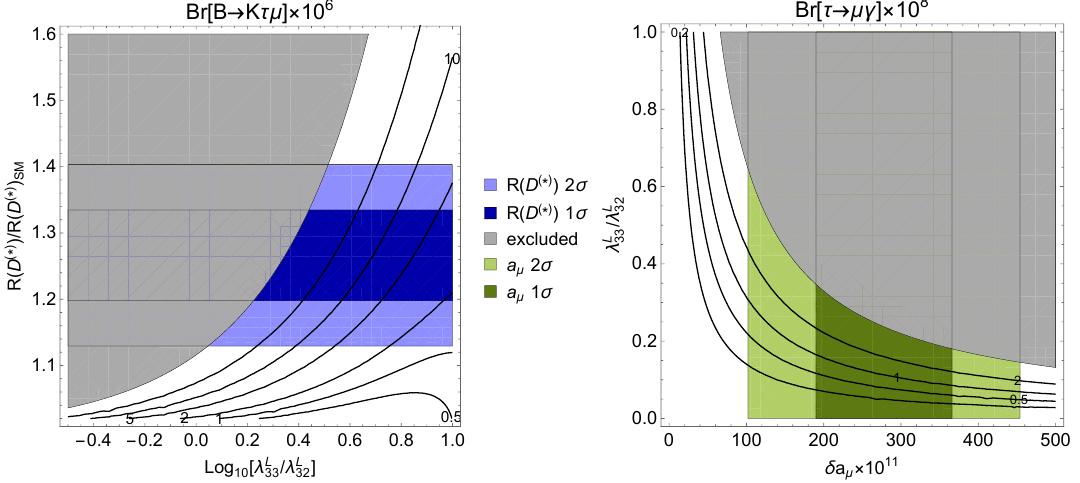
Figure 3 . Left: contours and excluded region for B K(cid:28)(cid:22) = ( B K(cid:28) + (cid:22) (cid:0) + B K(cid:28) (cid:0) (cid:22) + ) = 2 ! ! ! for C 22 = 0 : 5, i.e. assuming that C 22 takes the central value obtained from the b s(cid:22) + (cid:22) (cid:0) (cid:12)t. 9 9 (cid:0) ! The colored regions are allowed by the various processes. For R ( D ) and R ( D (cid:3) ) we used again the weighted average for R ( D ( (cid:3) ) ) EXP =R ( D ( (cid:3) ) ) SM . Right: the contour lines show Br[ (cid:28) (cid:22)(cid:13) ] 10 8 . ! (cid:2) The gray region is excluded by the current upper limit and (light) red region is allowed by a (cid:22) at the (2 (cid:27) ) 1 (cid:27) level. Note that both (cid:14)a (cid:22) and (cid:28) (cid:22)(cid:13) are only a function of (cid:21) L =(cid:21) L and therefore 33 32 ! independent of b s(cid:22) + (cid:22) (cid:0) !